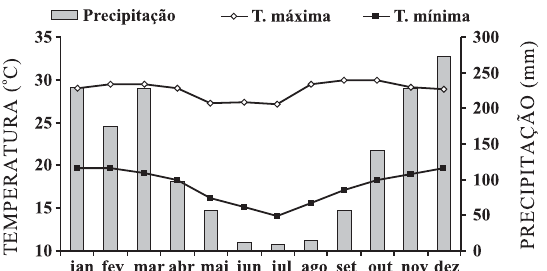
Figura 1. Temperatura média mensal (máxima e mínima) (°C) e precipitação pluvial média (mm) no bioma Cerrado em Rio Verde